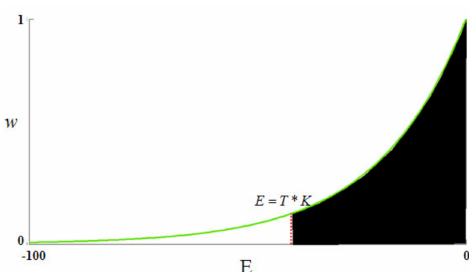
Figure 1. The profile of Equation (16) for a given h